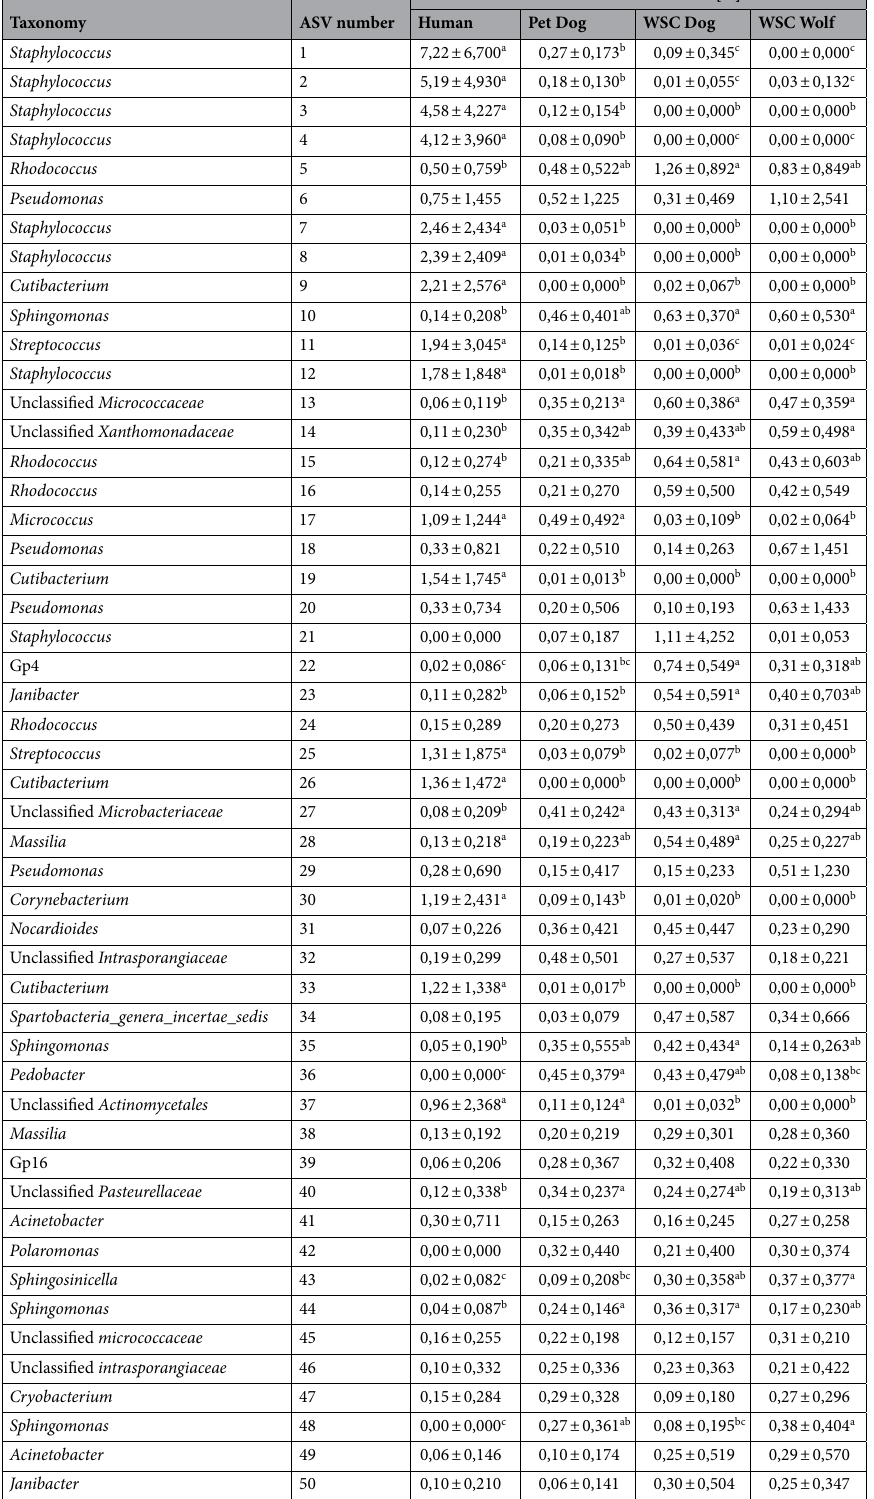
Table 1. The statistically significant differences in relative abundance among the 50 most abundant ASVs are shown for the human, pet dog, WSC dog und wolf group. Different superscripts in same row indicate statistical significance ( p value ≤